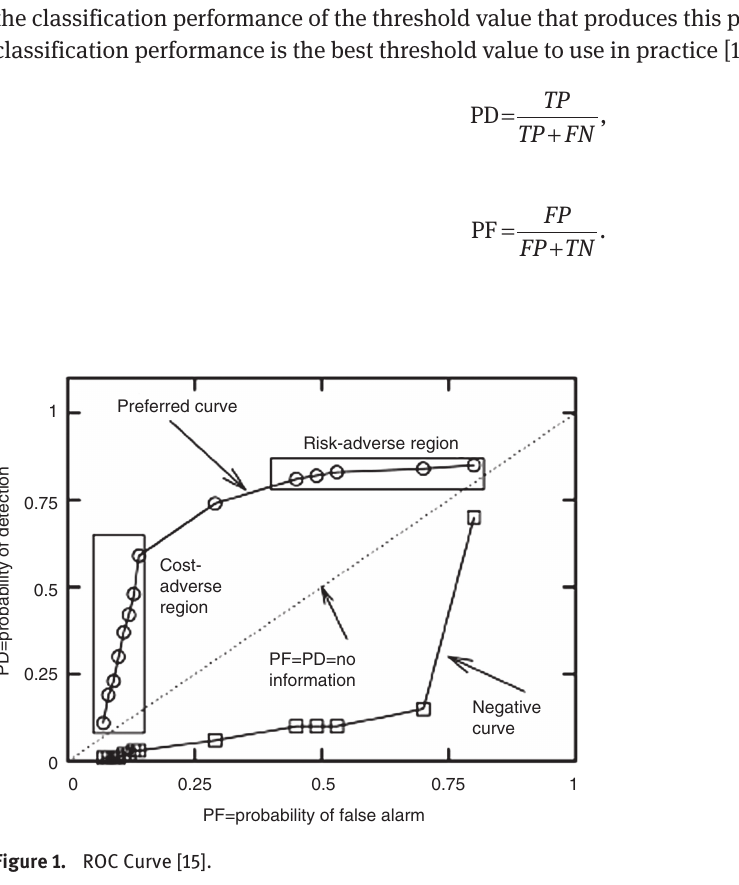
Figure 1. ROC Curve